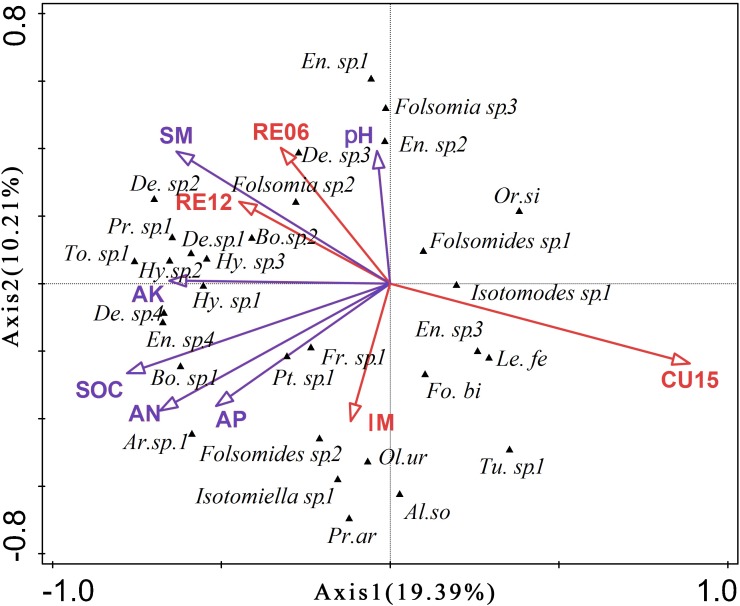
Redundancy analysis (RDA) diagram for soil Collembola communities across all sites.Bo. sp. 1, Bourletiella sp. 1; Bo. sp. 2, Bourletiella sp. 2; En. sp. 1, Entomobrya sp. 1; En. sp. 2, Entomobrya sp. 2; En. sp. 3, Entomobrya sp. 3; En. sp. 4, Entomobrya sp. 4; Le. Fe, Lepidocyrtus felipei; Or. Si, Orchesellides sinensis; Pt. sp. 1, Ptenothrix sp. 1; To. Ni, Tomocerus nigrus; De. sp. 1, Desoria sp. 1; De. sp. 2, Desoria sp. 2; De. sp. 3, Desoria sp. 3; De. sp. 4, Desoria sp. 4; Fo. Bi, Folsomia bidendata; Fr. sp. 1, Friesea sp. 1; Hy. sp. 1, Hypogastrura sp. 1; Hy. sp. 2, Hypogastrura sp. 2; Hy. sp. 3, Hypogastrura sp. 3; Pr. sp. 1, Proisotoma sp. 1; Ar. sp.1: Arrhopalites sp.1; Al. so: Allonychiurus songi; Ol. ur: Oligaphorura ursi; Pr. ar: Protaphorura armata; Tu. sp. 1: Tullbergia sp. 1.